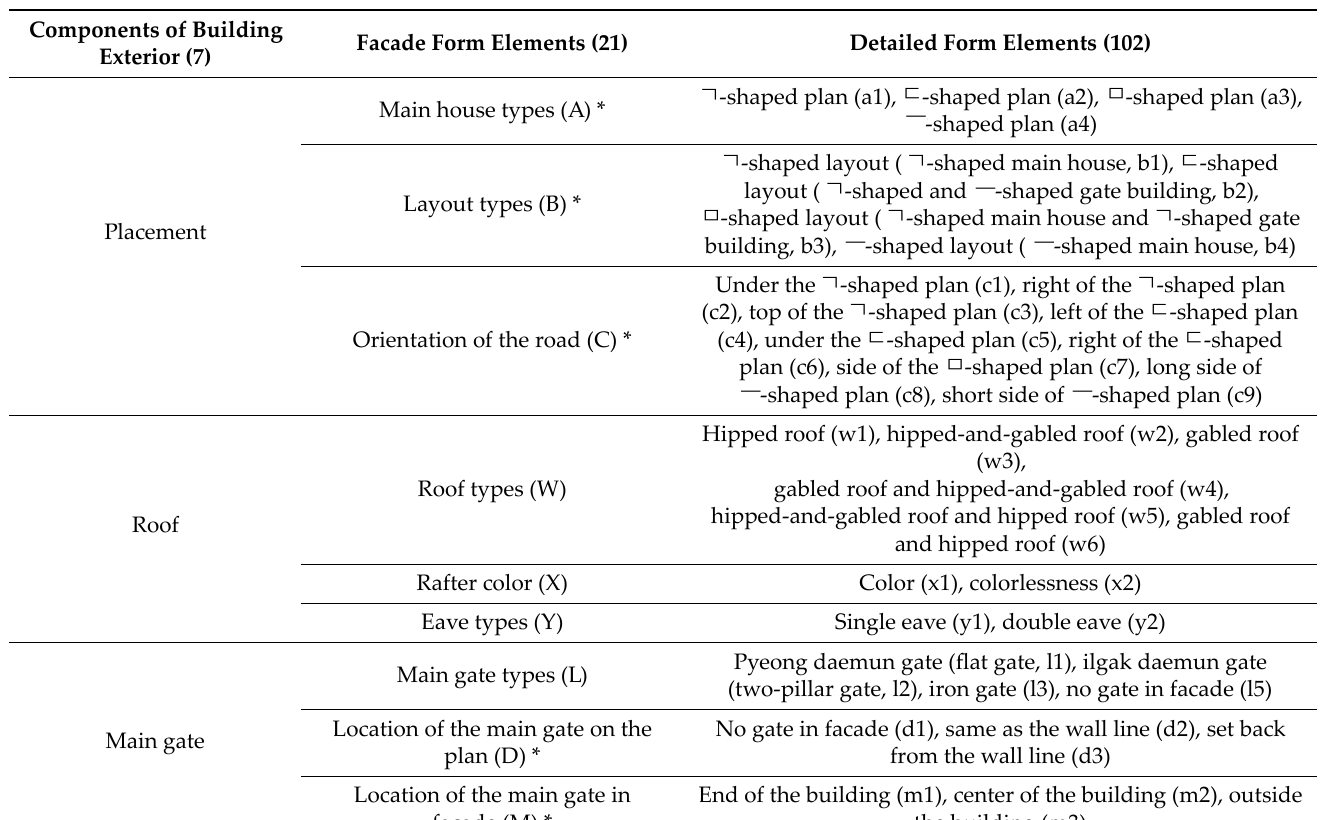
Table 1. Components of building exterior and form elements of Hanok.